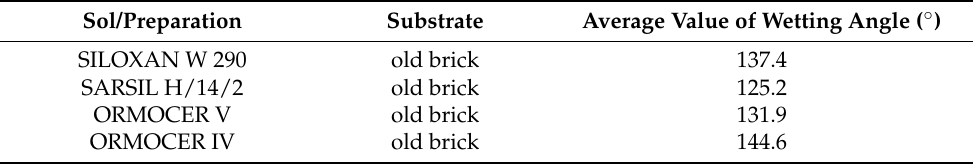
Table 4. Wetting angle values of old